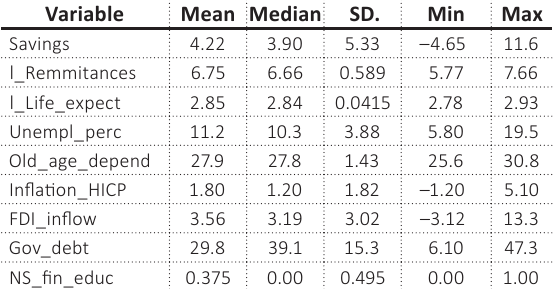
Table 5. Table 2. Summary statistics